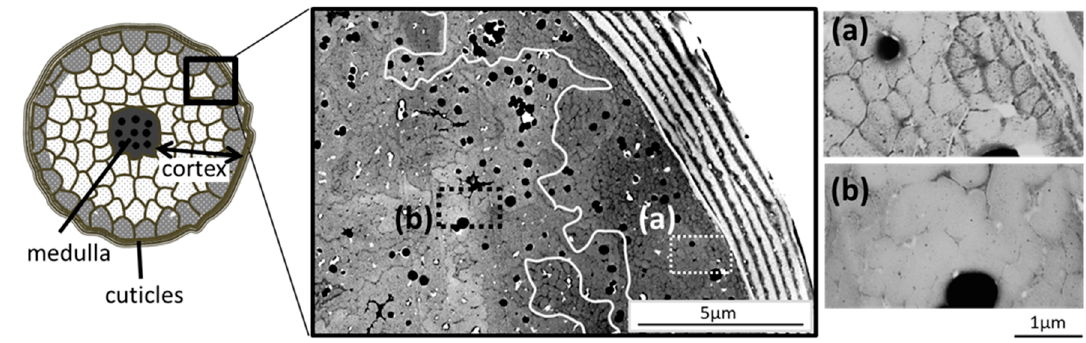
Figure 4. The distribution of two types of cortices in SHINAYAKA (flexible/elastic) hair. ( a ) Ortho-like cortex, ( b ) para-like cortex [18].